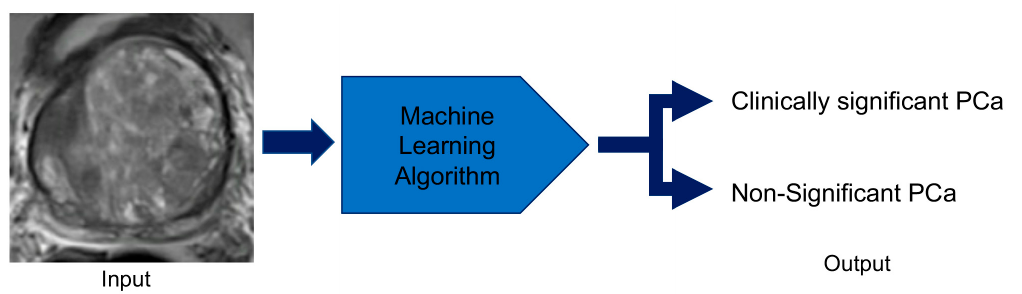
Figure 6. Prostate lesion characterization using machine-learning techniques. The computer receives multiparametric magnetic imaging images of prostate lesions and applies the developed machine learning algorithm to categorize the lesion as clinically significant prostate cancer or non-significant prostate cancer.